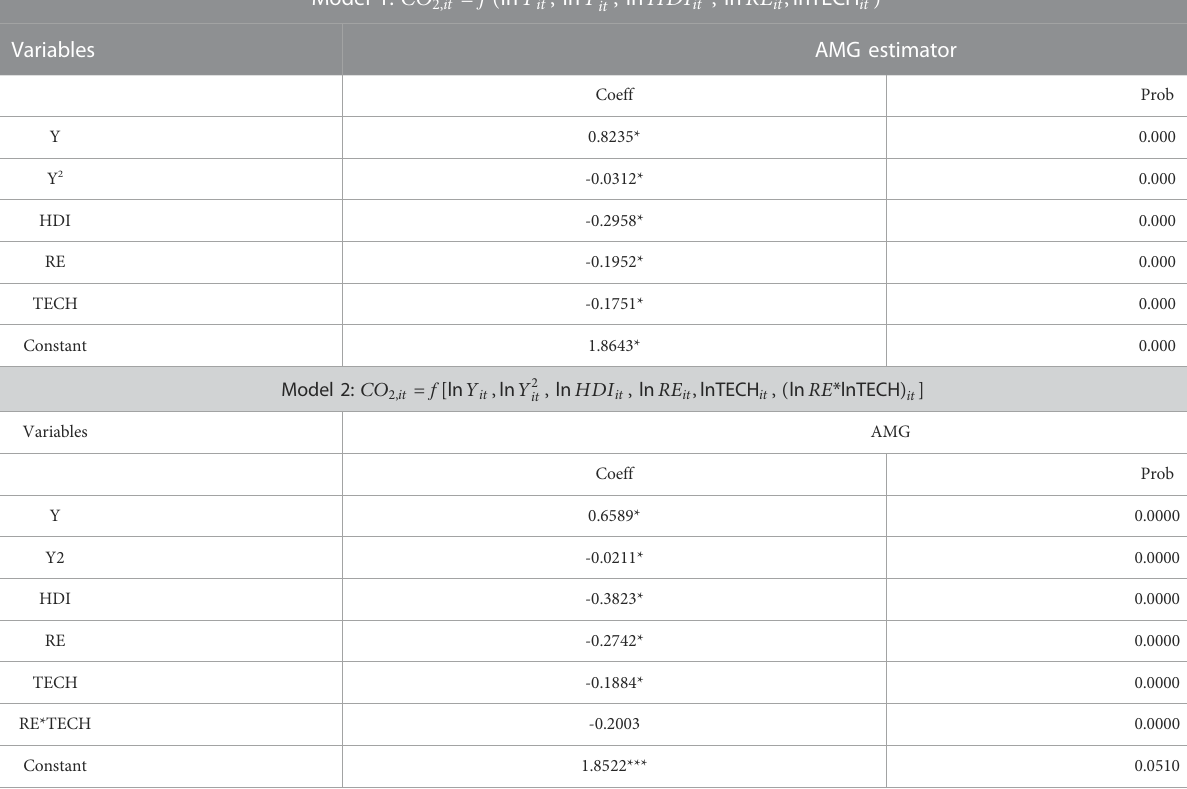
TABLE 8 AMG test